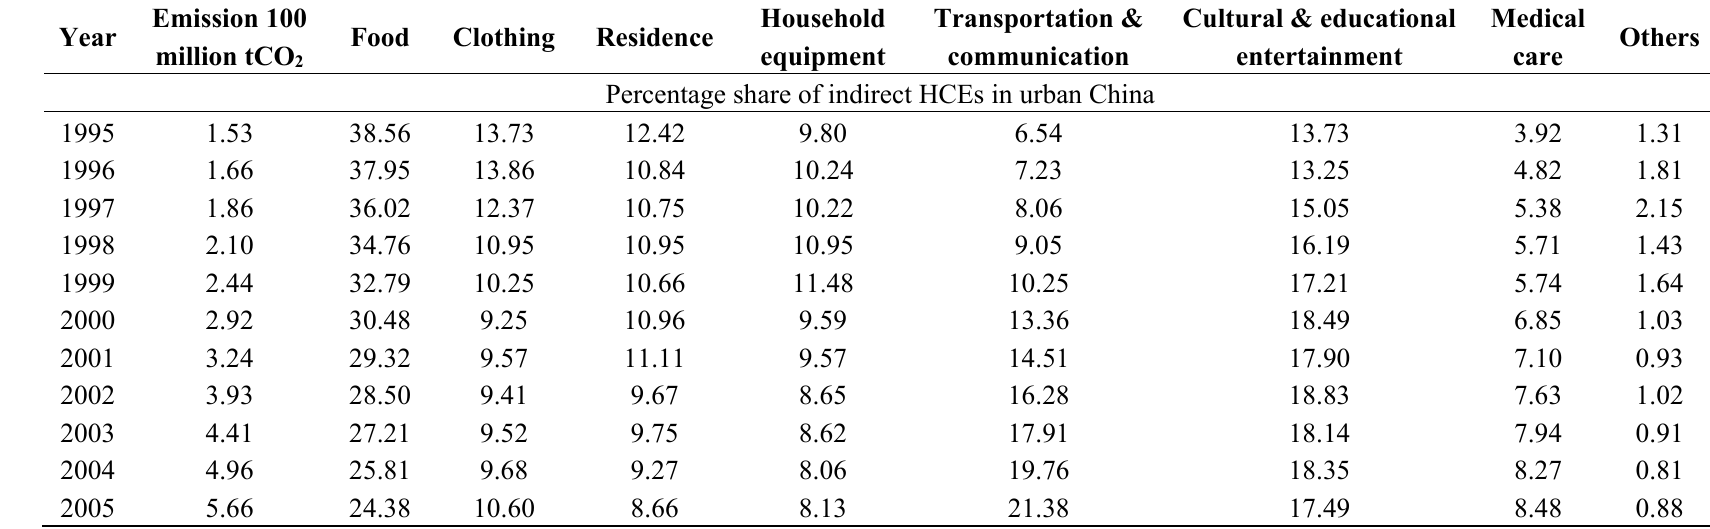
Table 4. Percentage share of HCEs by different indirect sources in rural and urban China, 1995–2011 (values in parentheses indicate decrease in percentage